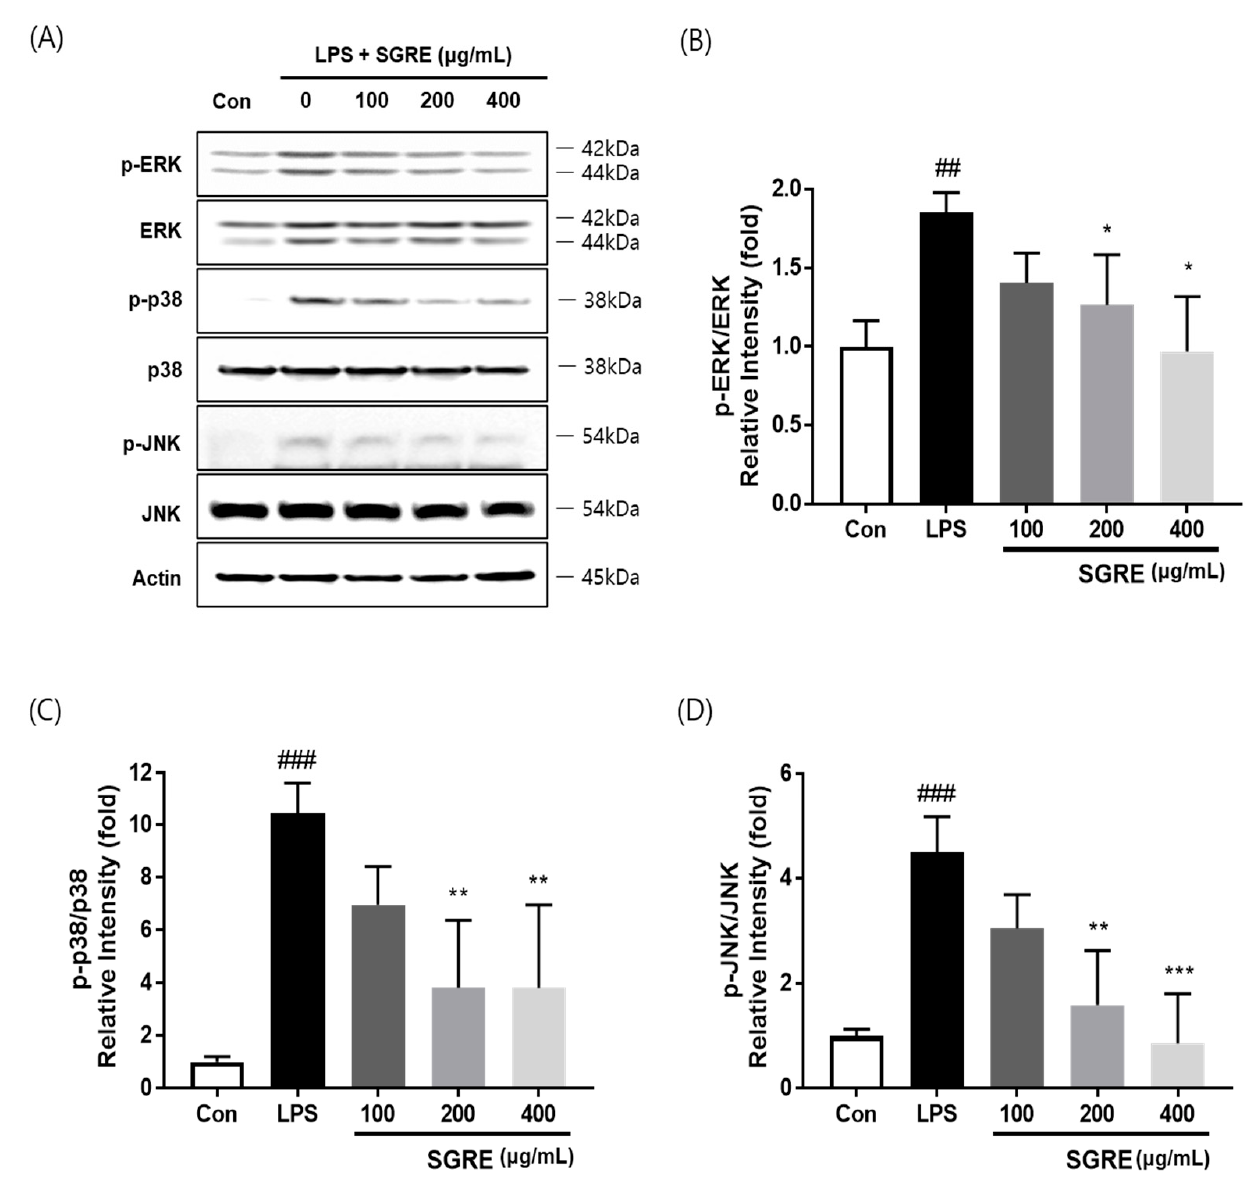
Figure 4. Effect of SGRE on the LPS-induced activation of the MAPK signalling pathway in RAW264.7 cells. ( A ) Representative Western blotting images of phosphorylated and total ERK, p38, and JNK. ( B – D ) Fold-change quantification of p-ERK ( B ), p-p38 MAPK ( C ), and p-JNK ( D ). ## p < 0.01; ### p < 0.001 vs. control cells. * p < 0.05; ** p < 0.01; *** p < 0.001 vs. LPS-treated cells.